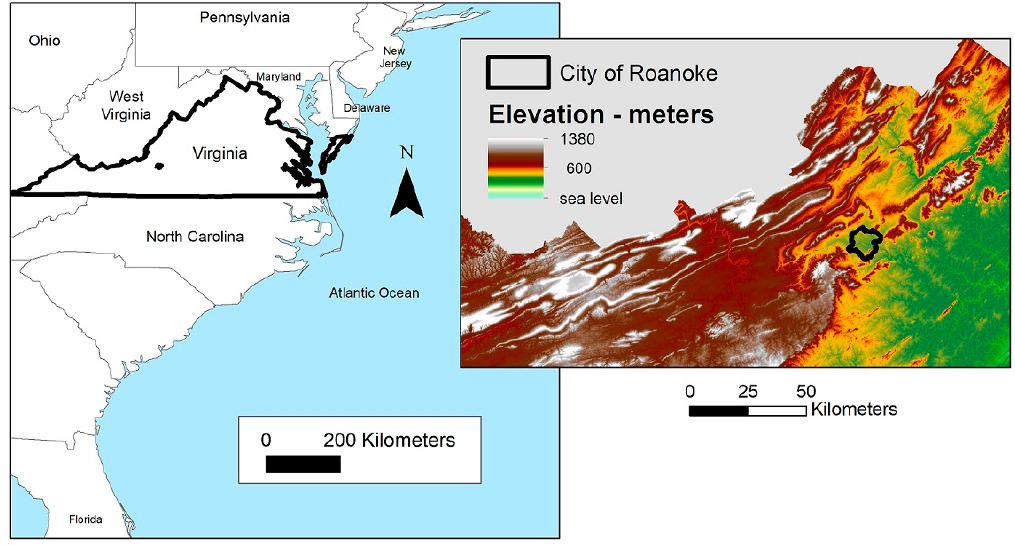
Figure 1. City of Roanoke, Virginia reference map (image on right generated from the Virginia digital elevation model).